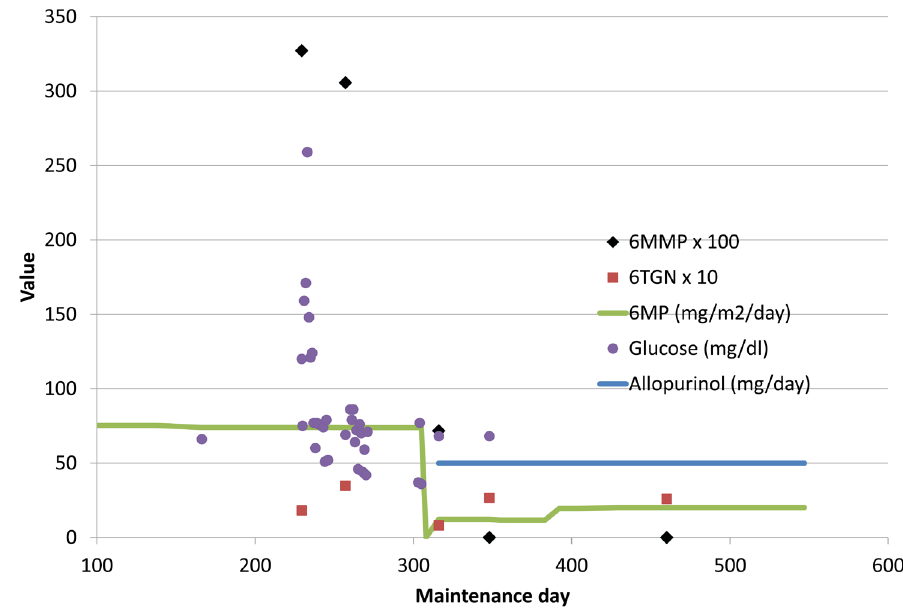
Figure 2. Treatment regimen for patient in Case 2. On the horizontal axis is the day of maintenance therapy from the start to completion. On the vertical axis are the red cell thiopurine metabolite values and drug doses. For graph clarity, 6-methyl-mercaptopurine (6MMP) values were divided by 100 and 6-thioguanine nucleotide (6TGN) values by 10. After introduction of allopurinol, the 6MMP levels rapidly fell to undetectable levels with stable 6TGN. Of note the high glucose values during dexamethasone pulses resolved after introduction of metformin on day